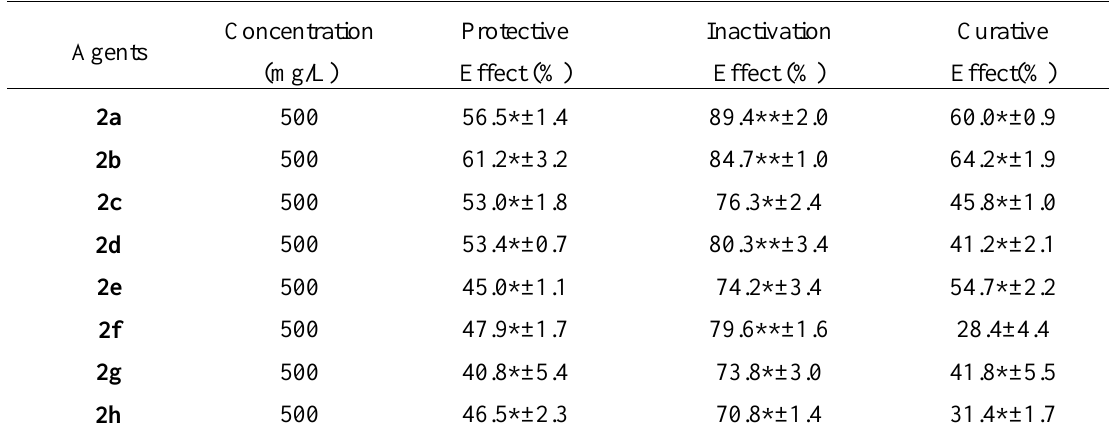
Table 3. The Protective, inactivation and curative effects of the new compounds against TMV in